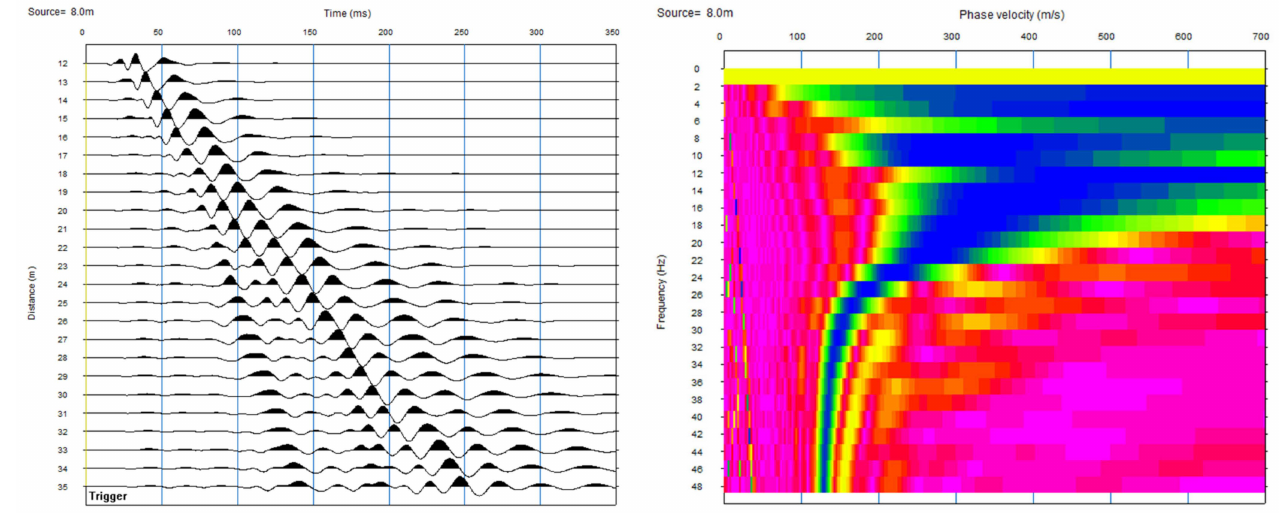
Figure 4. Generation of the dispersion image after transformation of the shot record from the time ( left ) to the frequency ( right )